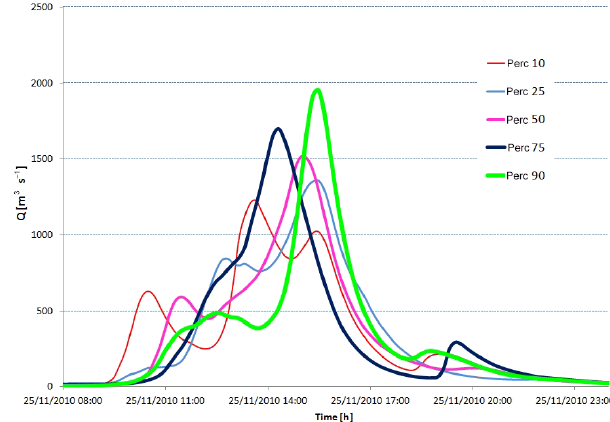
Figure 7. Streamflow scenarios derived by RSs = 4km and RSt = 3h. The hydrographs that lead to the peak flows with 10th, 25th, 50th, 75th, and 90th percentiles were